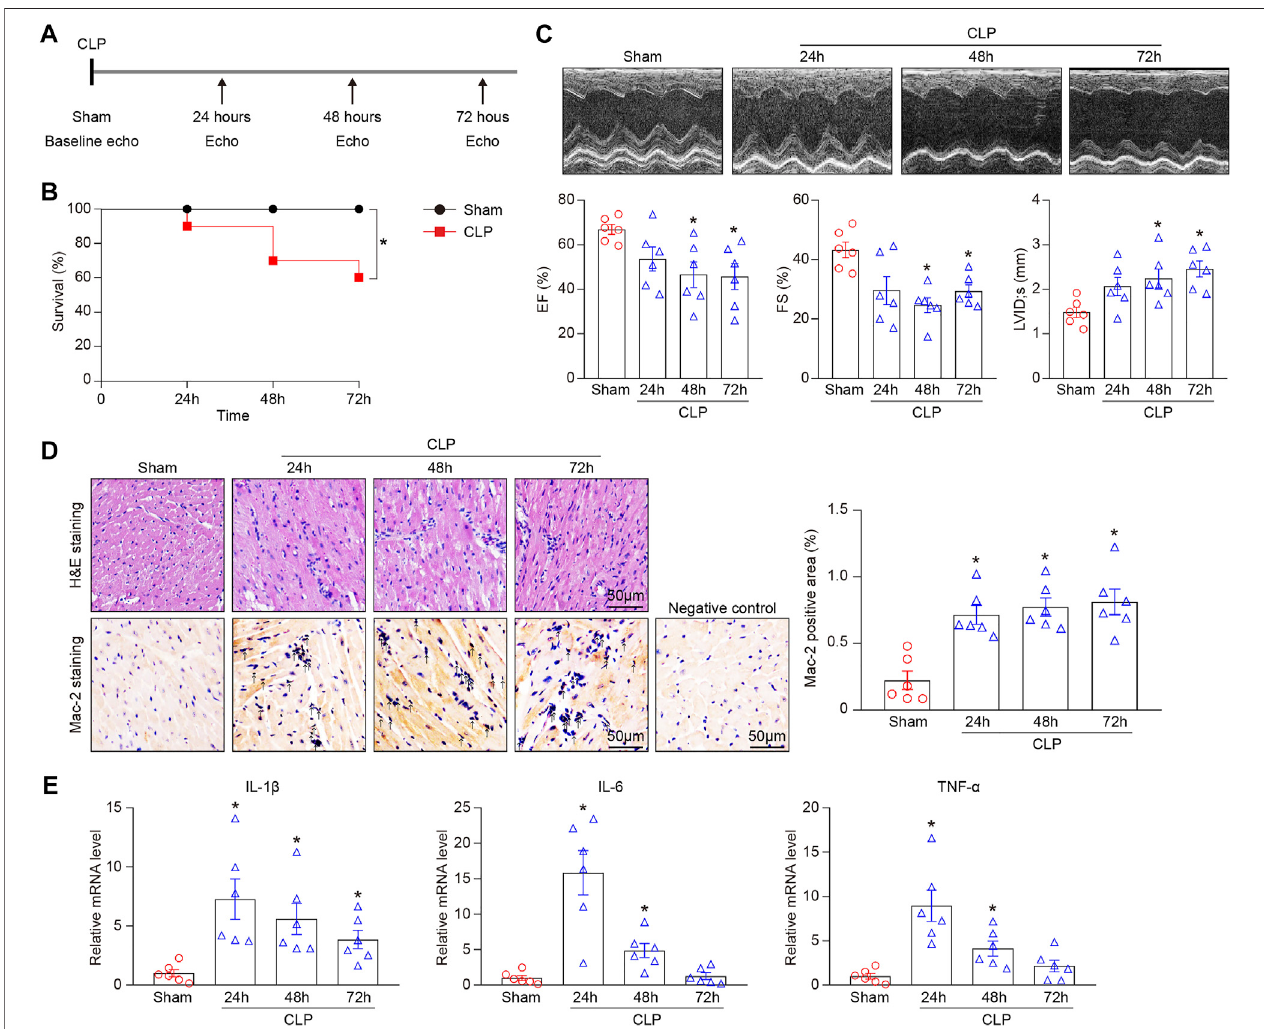
FIGURE 1 | CLP-induced sepsis results in animal death and myocardial injury in mice. Mice were subjected to CLP for 24, 48, and 72 h. (A) Schematic diagram of the experimental design. (B) Kaplan-Meier survival analysis (n = 10 per group). (C) Representative M-mode echocardiographic images of left ventricular at 24, 48, and 72 h after CLP surgery (top). Quanti fi cation of EF%, FS%, and LVID;s (bottom, n = 6 per group). (D) Representative images of H&E staining (top) and Mac-2 immunohistochemicalstaining(bottom)ofheartsections.ArrowsindicatetheMac-2 – positivecells.Scalebar:50 μ m.Quanti fi cationofMac-2 – positivecells(right,n = 6 per group). (E) qPCR analyses of the mRNA expression levels of IL-1 β , IL-6, and TNF- α in septic myocardium (n = 6 per group). GAPDH as an internal control. The Kaplan-MeiermethodwasusedtoanalyzethemortalityratesafterCLPoperation.Thesigni fi canceofdifferencebetweenthemeansofgroupswasevaluatedusingOne- way ANOVA following Newman-Keuls multiple comparison test. * p < 0.05 versus sham